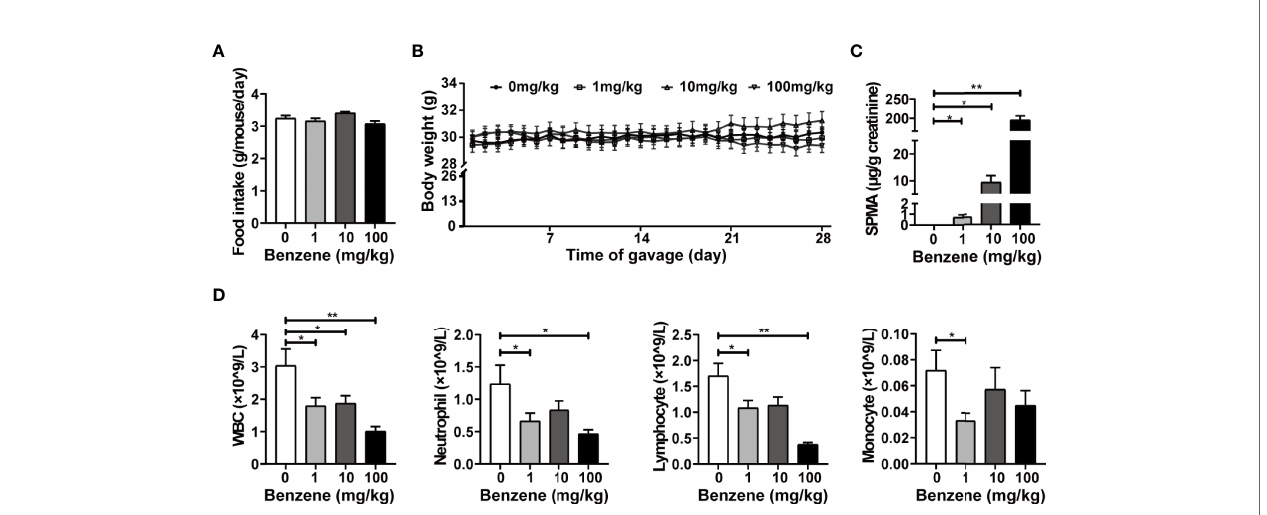
FIGURE 1 | Exposure of benzene-induced hematotoxicity in mice. Average food intake (A) and body weight gain kinetic (B) during the period of benzene exposure were measured. The internal exposure level of benzene was re fl ected by urinary SPMA corrected by creatinine (C) . The count of peripheral blood cells (D) including white blood cells (WBC), neutrophils, lymphocytes and monocytes was determined after benzene exposure. Data are presented as mean ± SD (n = 11-12), and one way ANOVA were performed; * p < 0.05, ** p < 0.001 (compared to the control group).